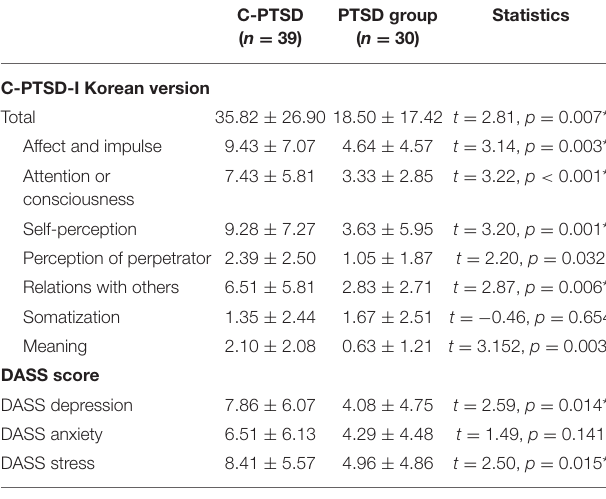
TABLE 2 | Comparison of complex PTSD-I and DASS scores between the complex and non-complex PTSD